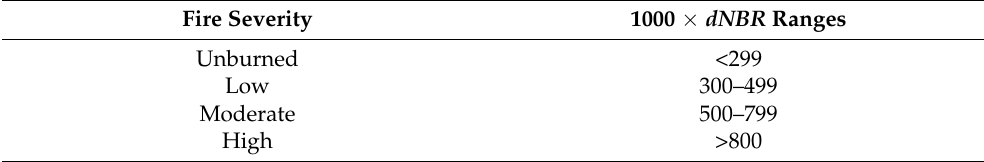
Table 3. Threshold range for forest fire